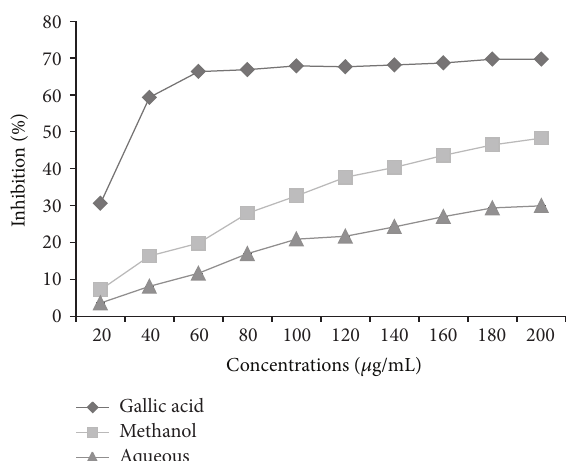
Figure 5: Hydroxyl radical scavenging activity of leaves extracts of P. aculeata L. and gallic acid (results are represented mean ± SE of triplicate experiment).